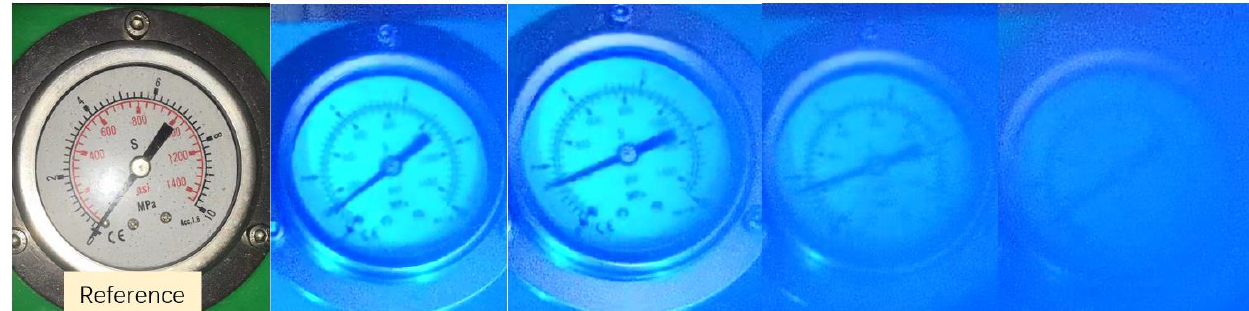
Figure 19. Pressure of arm cylinder during the 2020 sea trials.